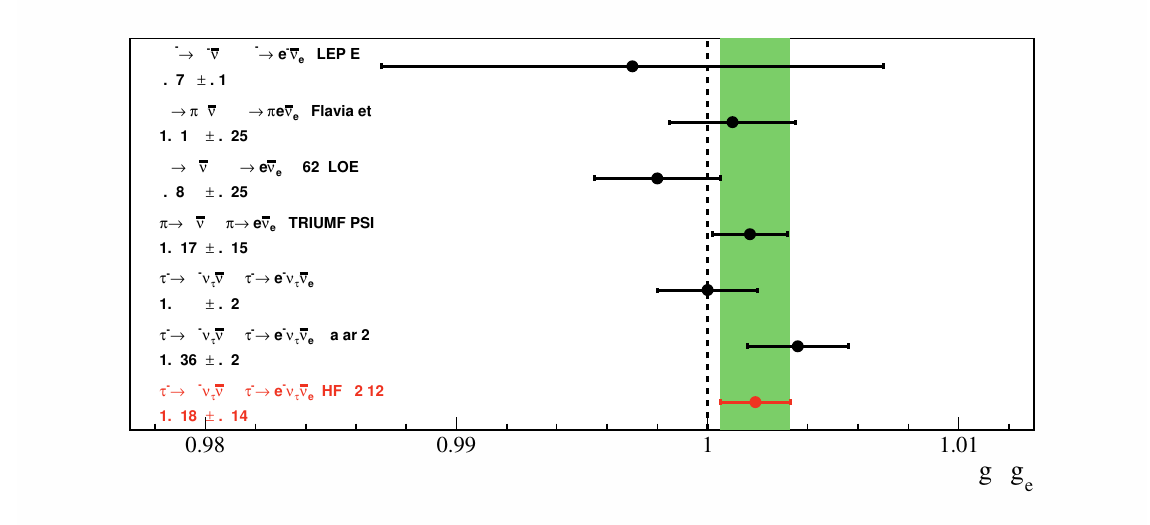
Figure 4. The current status of g μ /g e lepton universality measurements. The B A B AR measurement is from [5], while the HFAG values are from[1]. The HFAG average [1] is the weighted average of previous τ results with the recent B A B AR g μ /g e measurement. The τ measurements from before B A B AR are from [69]. The other measurements are taken from [1, 84].